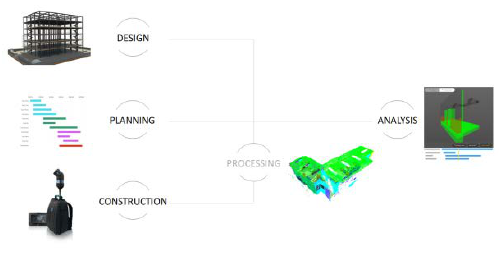
Figure 1. Proposed workflow.